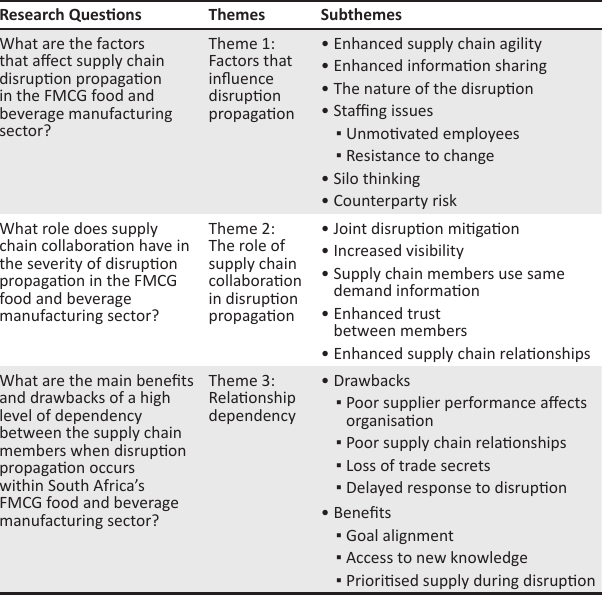
TABLE 2: Summary of themes and sub-themes. Research